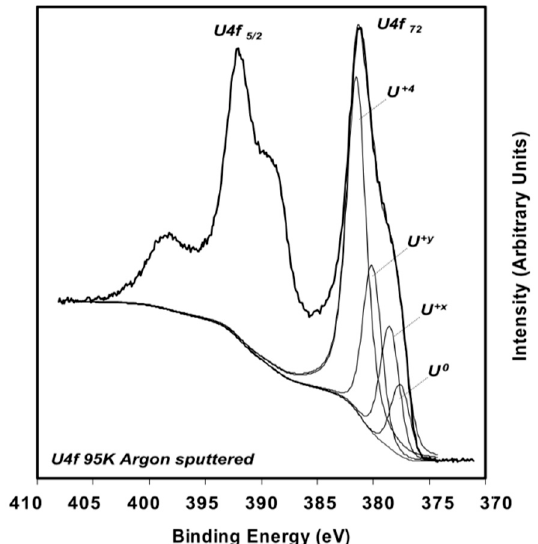
Figure 3. XPS spectra of reduced UO 2 (111) surface [49]. The broad shoulder of U4 f 7 / 2 peak can be Figure 4. XPS spectra of reduced UO 2 (111) surface [49]. The broad shoulder of U4 f 7/2 peak can be better fitted by considering di ff erent oxidation states of uranium from + 4 to better fitted by considering different oxidation states of uranium from +4 to 0.